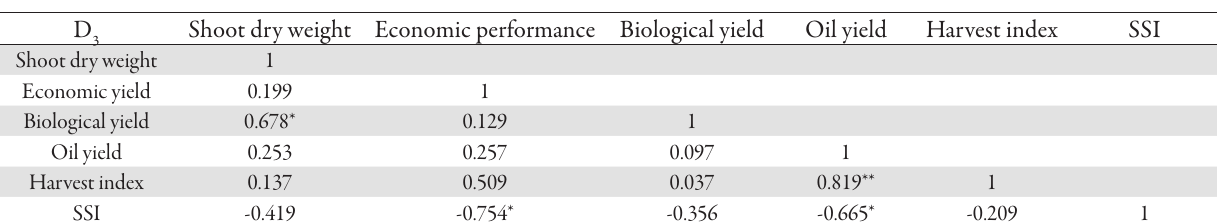
Tab. 5. Correlation between dry matter, economic performance, biological yield, oil yield, harvest index and stress susceptibility index (SSI) characteristics in the third level of stress (stress in the beginning stage of stem elongation to early emergence of sacs,